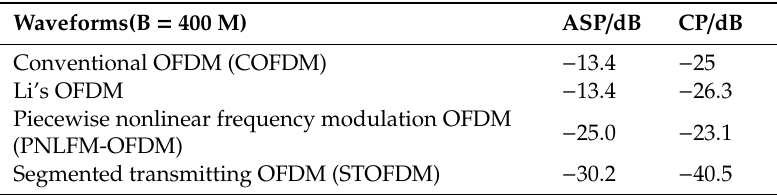
Table 4. ASP and CP of previous and designed signals.